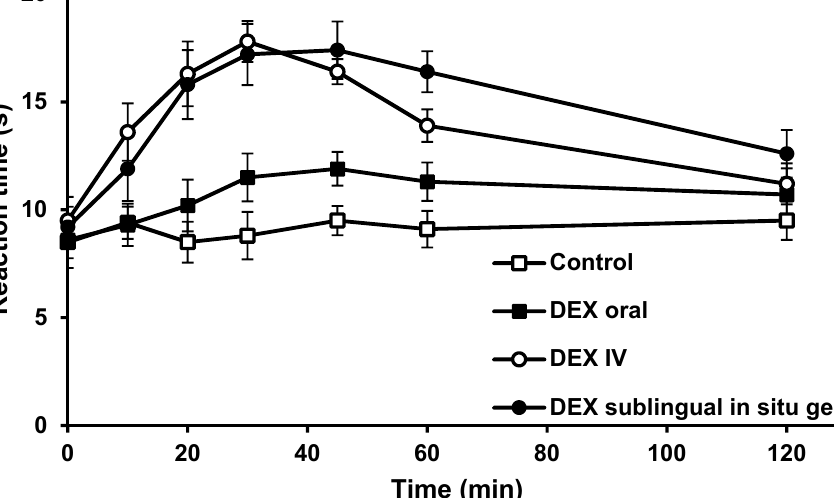
Figure 4. Reaction times in rats following sublingual administration of DEX in situ gel (F3), oral and IV administrations of DEX free drug solutions, as measured by the hot plate method.